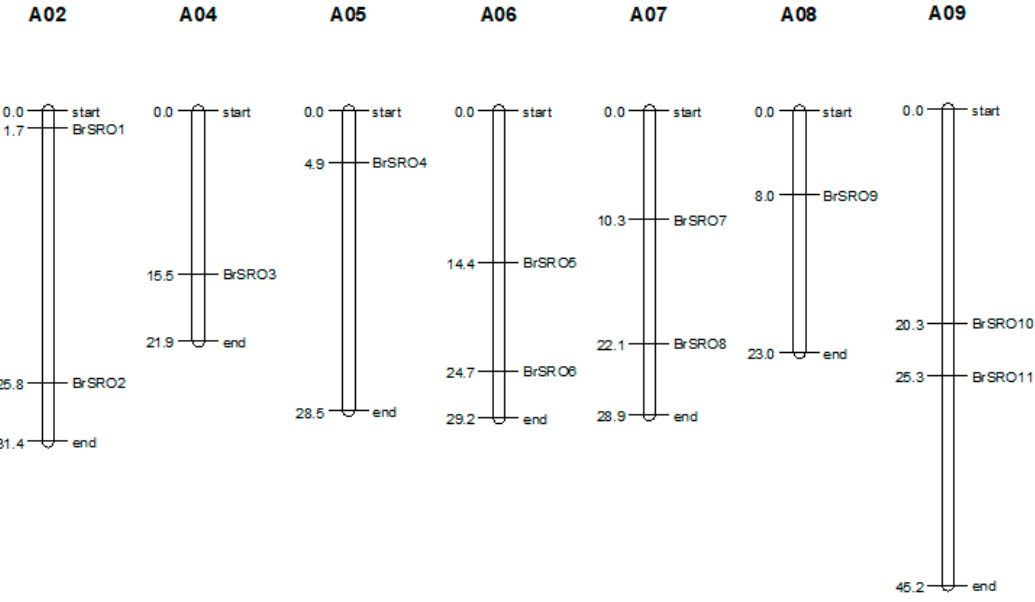
Figure 1. The chromosomal mapping analysis of the SRO gene family in Chinese cabbage. The chromosome number (A02–A09) is indicated at the top of each chromosome. The numbers on the left of each chromosome represent the initial position of each gene.